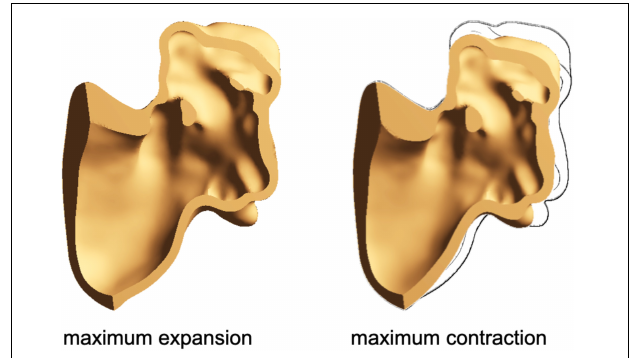
FIGURE 3 | Cross-section of the chicken wing model at the maximum expansion (left) and at the maximum contraction (right) .